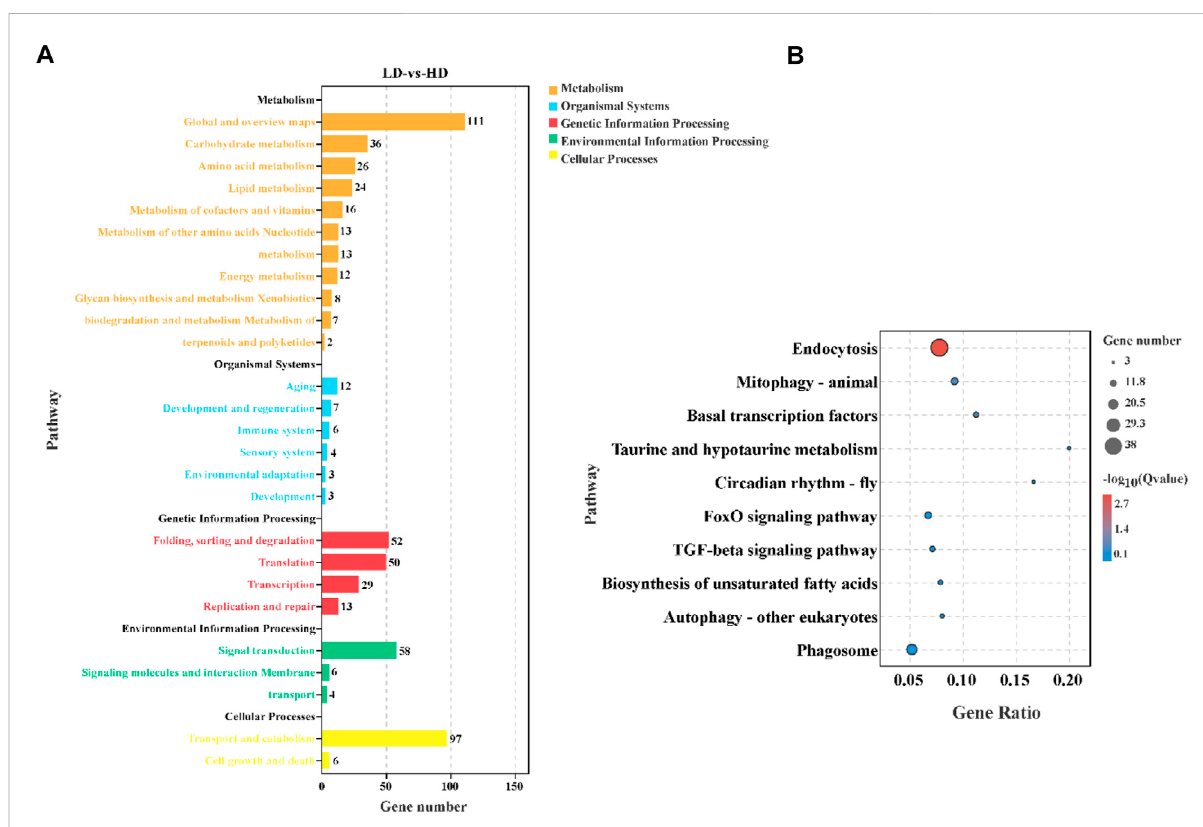
FIGURE 5 KEGG enrichment analysis in the hepatopancreas of C. quadricarinatus under two stocking densities (LD-vs-HD). (A) The result of DEGs enrichment in the KEGG. (B) The top 10 enriched KEGG